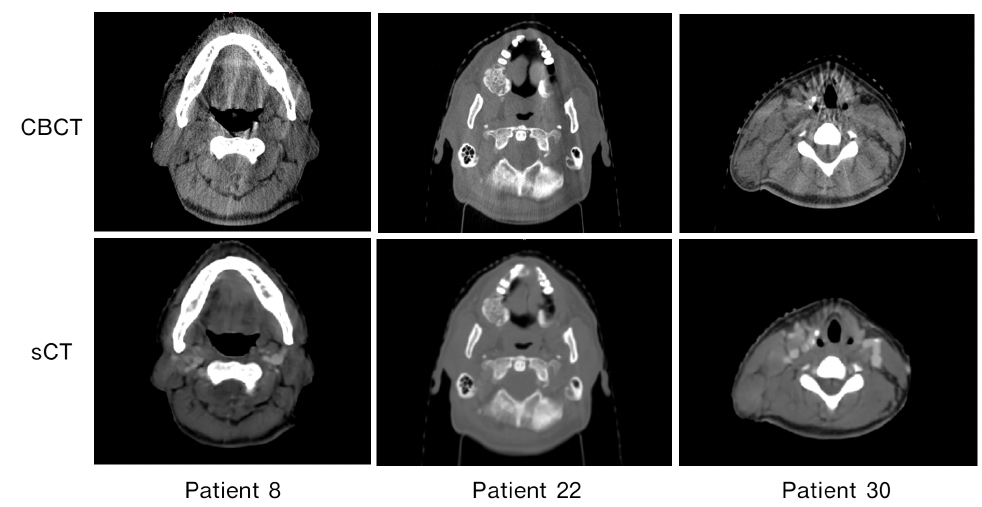
Figure 11. Comparison of CBCT and sCT on axial slices of patients with the three highest average MAEs (Patients 8, 22, and 30).